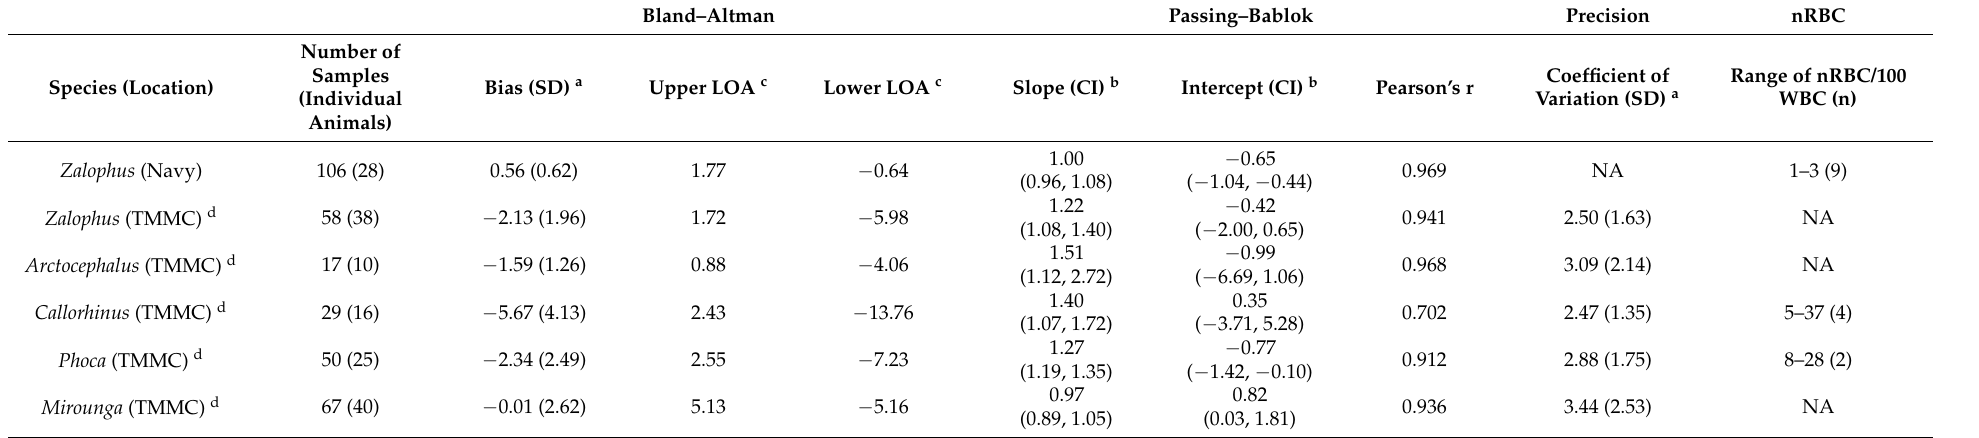
Table 1. Summary of method comparison results for white blood cell counts in five species of pinnipeds: California sea lions ( Zalophus californianus ) from the U.S. Navy Marine Mammal Program (CSL MMP), California sea lions from The Marine Mammal Center (CSL TMMC), Guadalupe fur seals ( Arctocephalus townsendi ; GFS; TMMC), Northern fur seals ( Callorhinus ursinus ; NFS; TMMC), harbor seals ( Phoca vitulina ; HS; TMMC), and Northern elephant seals ( Mirounga angustirostris ; ES;